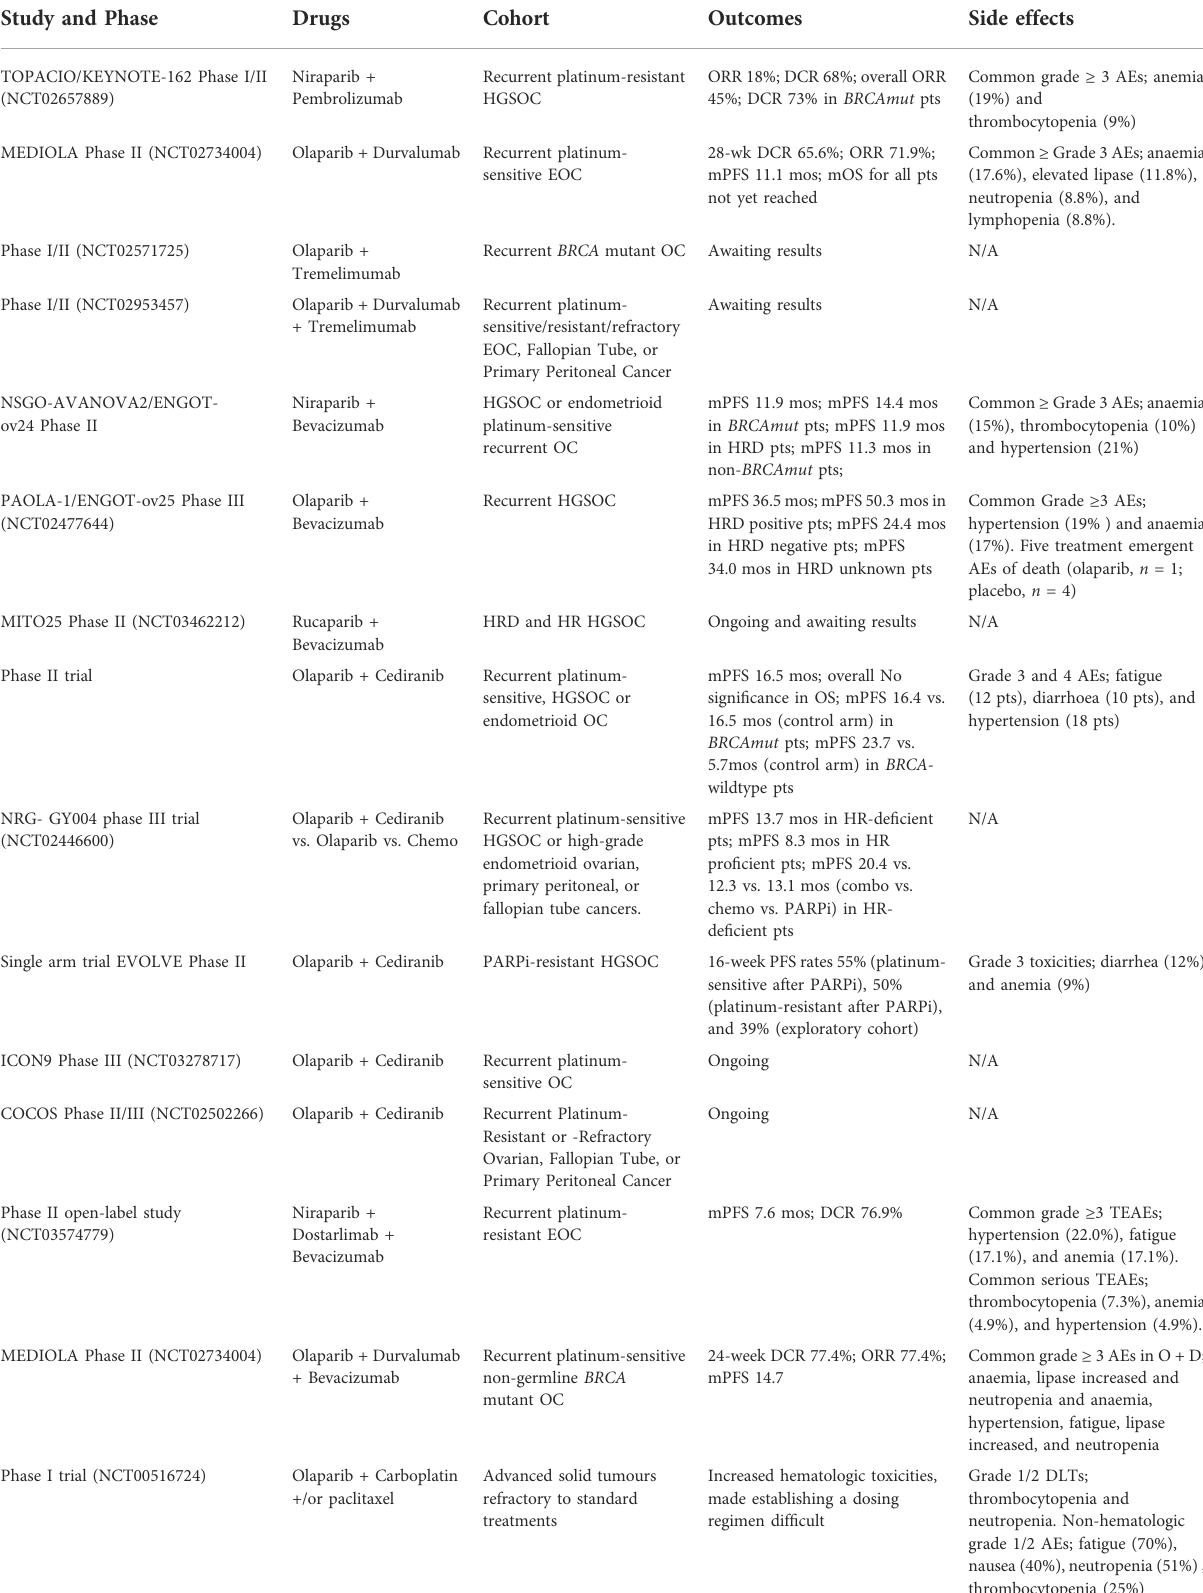
TABLE 1 Clinical trials combining PARP inhibitors with chemotherapy or with therapeutics with relevance for the immune system. This includes immune checkpoint inhibitors and/or angiogenesis agents in order to attempt to elicit more robust and durable